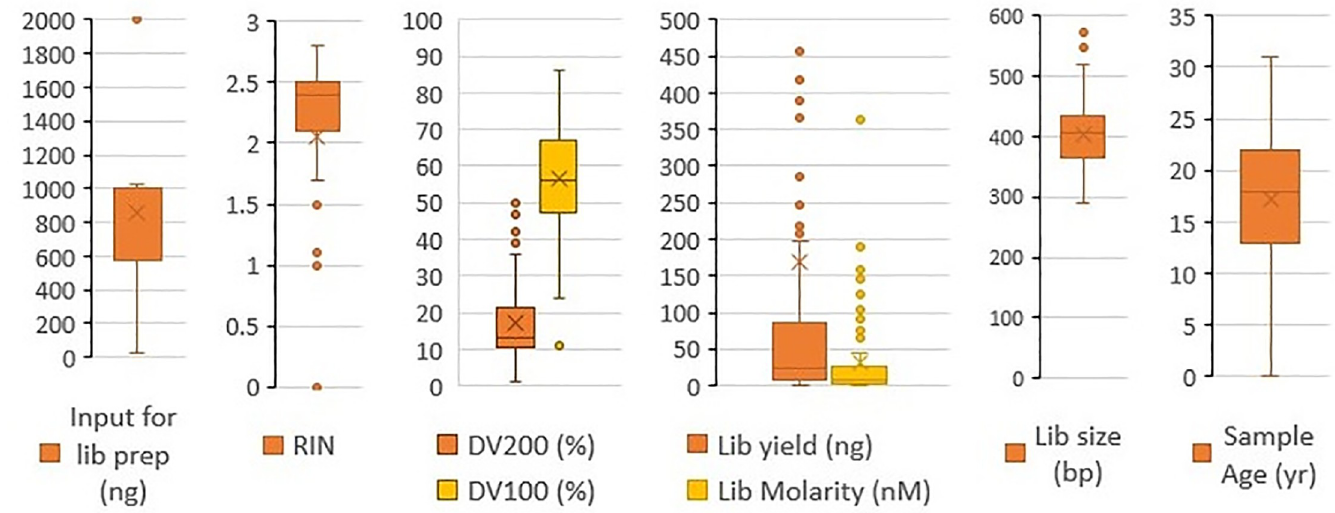
Fig 1. Sample and library QC box plots. The plots the median, mean and standard deviation of sample storage age, RIN, fragment distribution values (DV) (DV 200 and DV 100 ), input amount for library, library yield, library molarity, and library size distributions. For each box and whisker plot, the middle line of the box represents the median, and the ‘x’ represents the mean.The top and bottom lines represent 75th and 25th percentile, respectively. The whiskers extend to the data point 1.5 times the interquartile range above the 3rd quartile or below the first quartile. Values outside this range are represented by dots. Extreme outliers in the plots for input for library preparation (4731 ng and 2000 ng) and library yield (5467.95 ng and 985.95 ng) have been omitted for clarity of visualization of the distributions. Values that could not be obtained are designated as N/A in Table 2 and were not included in Fig